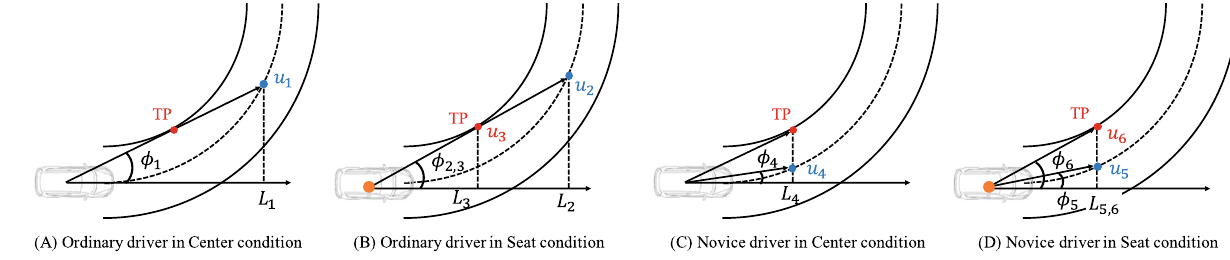
Figure 5. Definition of fixation points of ordinary and novice